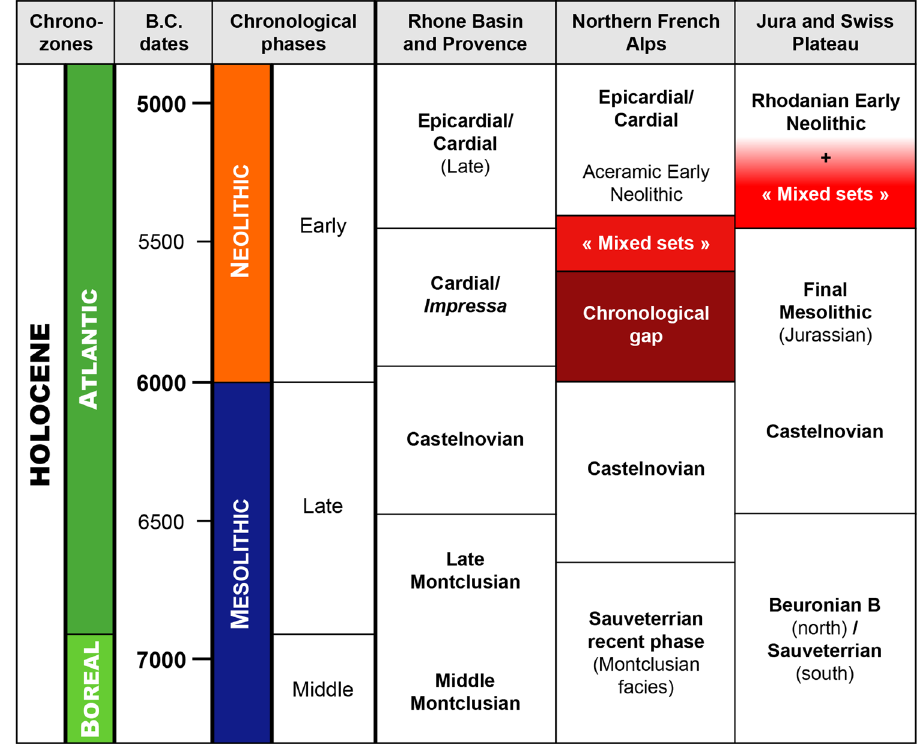
Figure 1: Chronocultural evolution of the Second Mesolithic to Early Neolithic in the Northern French Alps, the Rhone basin and Provence and the Jura and Swiss Plateau ( compilation of data from Bintz, Bocquet, Borel, & Olive, 1989; Bintz, 1991; Beeching, 1995; Bintz, Picavet, & Evin, 1995; Voruz, Nicod, & de Ceuninck, 1995; Perrin, 2001; Angelin, 2017 )